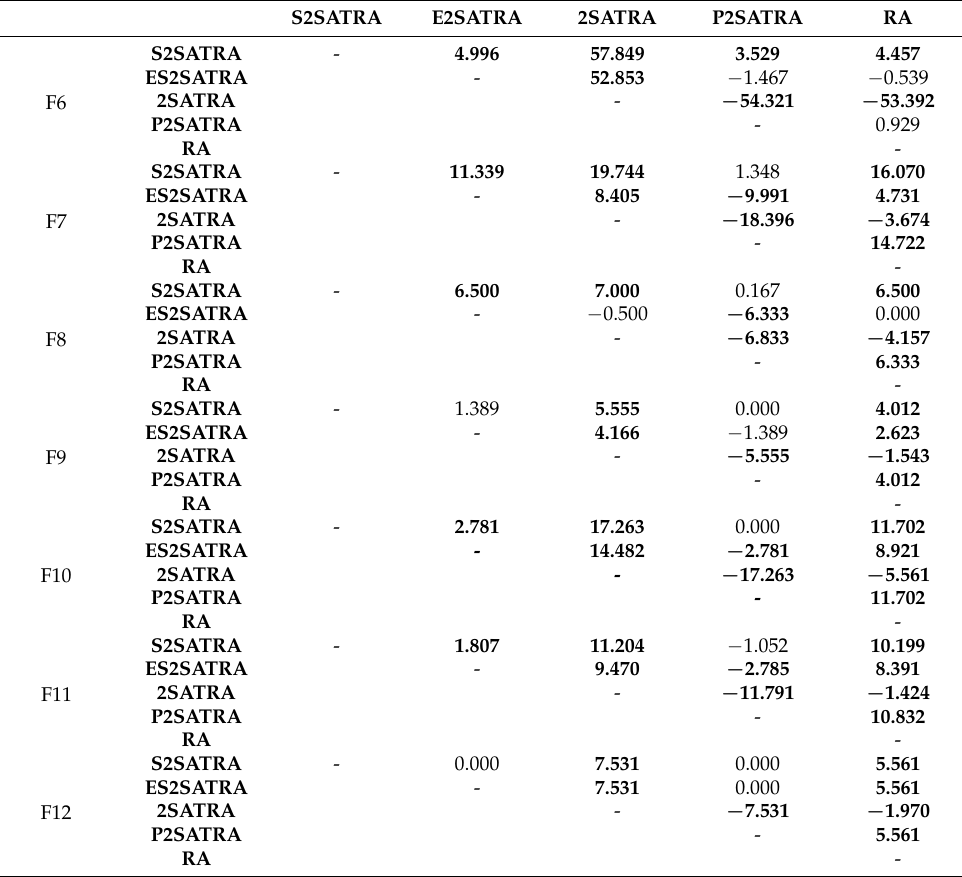
Table 15. McNemar’s statistical test for